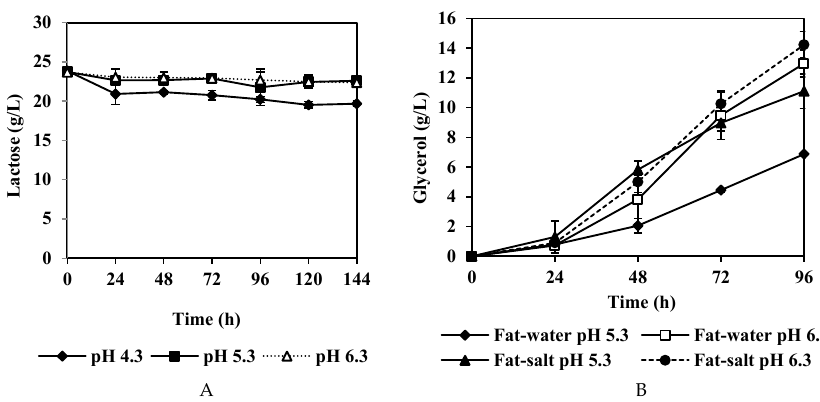
Figure 6. The changes in the ( A ) lactose content of the fat-free cream fraction inoculated with A. oryzae at different pH values and ( B ) glycerol concentration of the cream fat fraction inoculated with A. oryzae at different pH values and medium compositions.